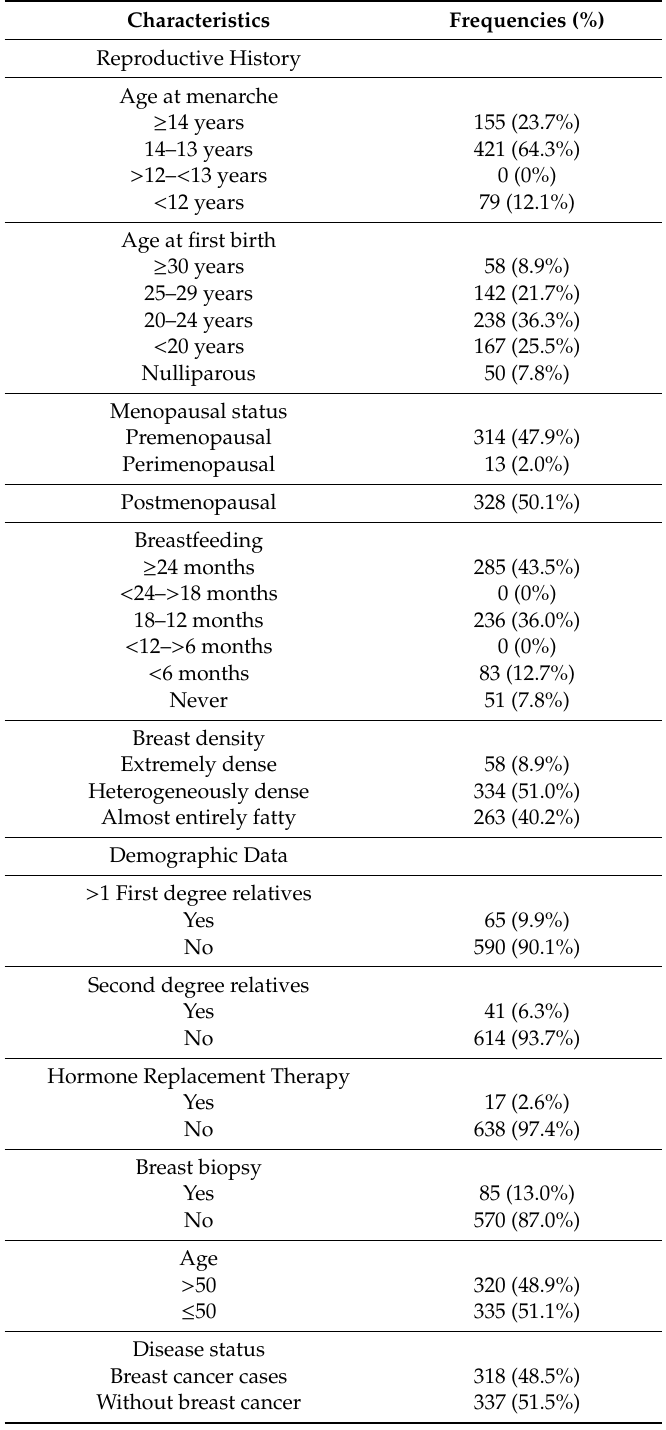
Table 1. The frequencies and percentages of variables in the datasets used for the model